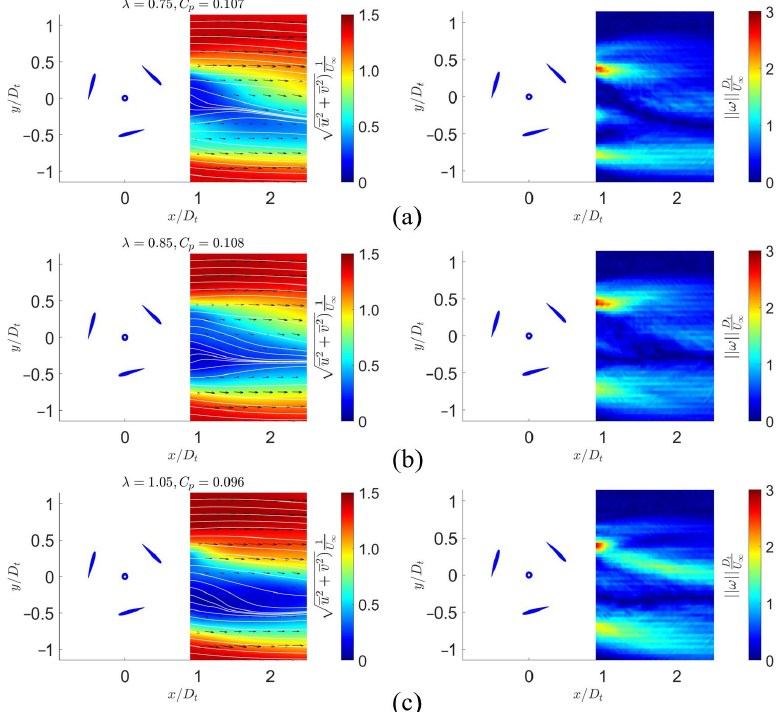
Figure 12. The time-averaged non-dimensionalized velocity and vorticity of the T2 configuration at λ = 0.75 ( a ), λ = 0.85 ( b ), and λ = 1.05 ( c ) with the associated power coefficients. The blue circle displays turbine T2 rotation